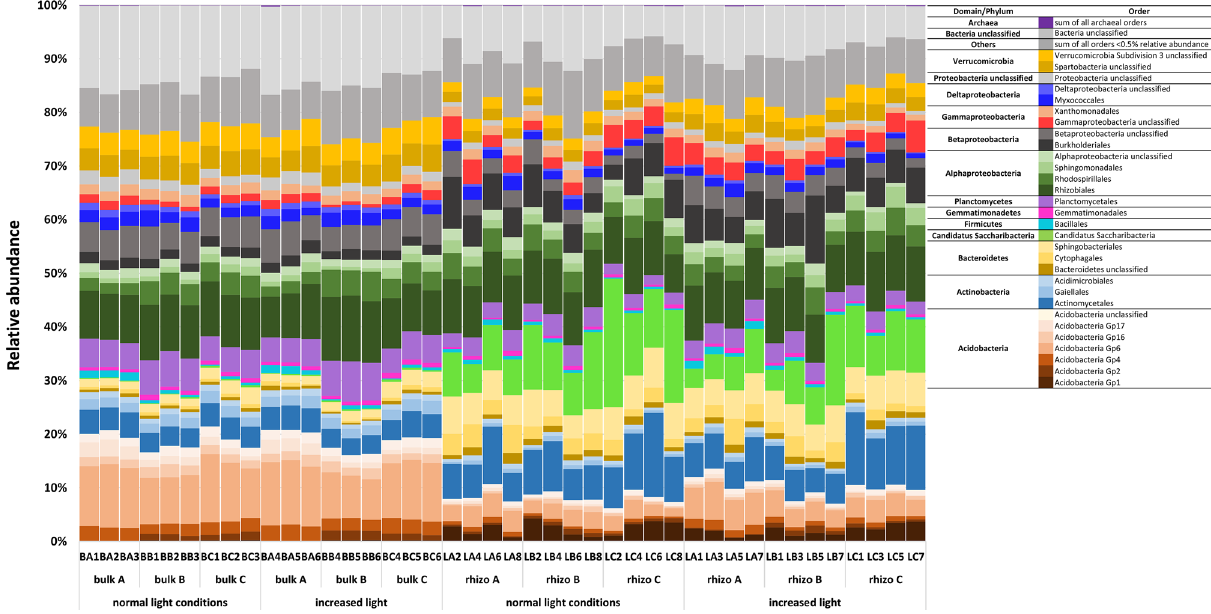
Figure 1. Community composition of prokaryotes on order level representing most abundant orders (95% of relative abundance) in bulk and rhizosphere (rhizo) soils at normal and increased light conditions. A,B,C represent the forest replicate sites. BA, BB, BC stand for bulk soils on site replicate A, B and C. LA, LB, LC stand for rhizosphere soil of L. decidua (L) on site replicate A, B and C. Numbers indicate replicates within fraction, site and light